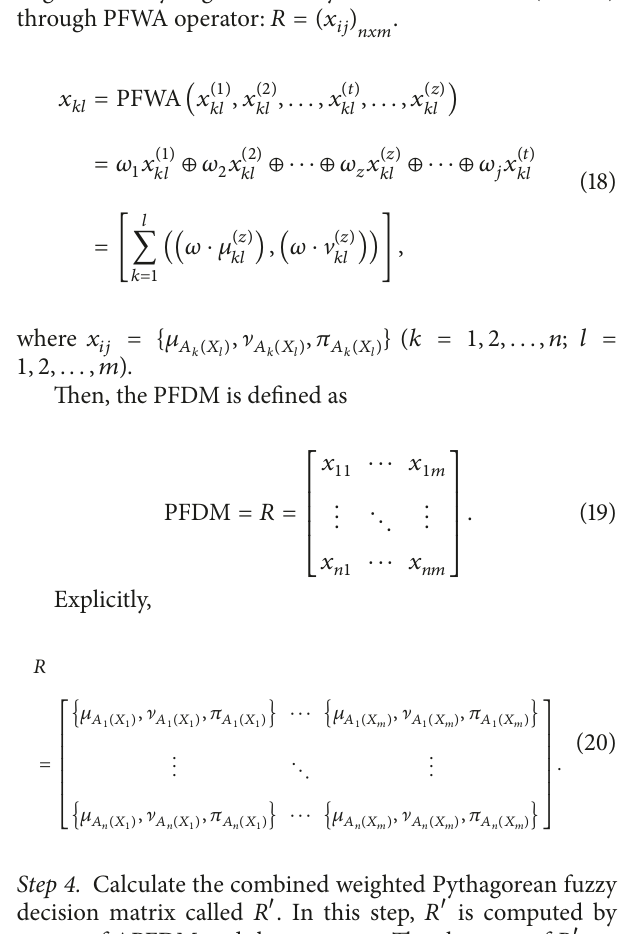
Table 2: Scale for assessment alternatives. Meaning PFNs (𝜇, ] )